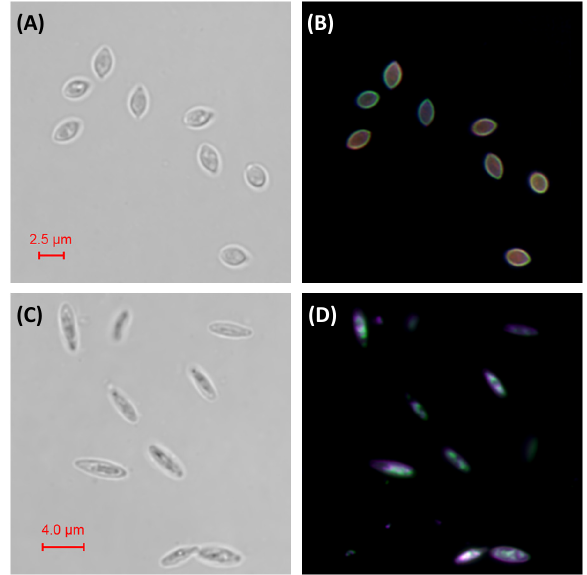
Fig. 7. Fluorescence microscopy images of fungal spores from lab cultivation of the two fungi ( Ascomycota ) with previously unknown IN activity: (A–B) Isaria farinosa , (C–D) Acremonium implicatum . Left panels show bright-field image and right panels show overlay of red, green, and blue